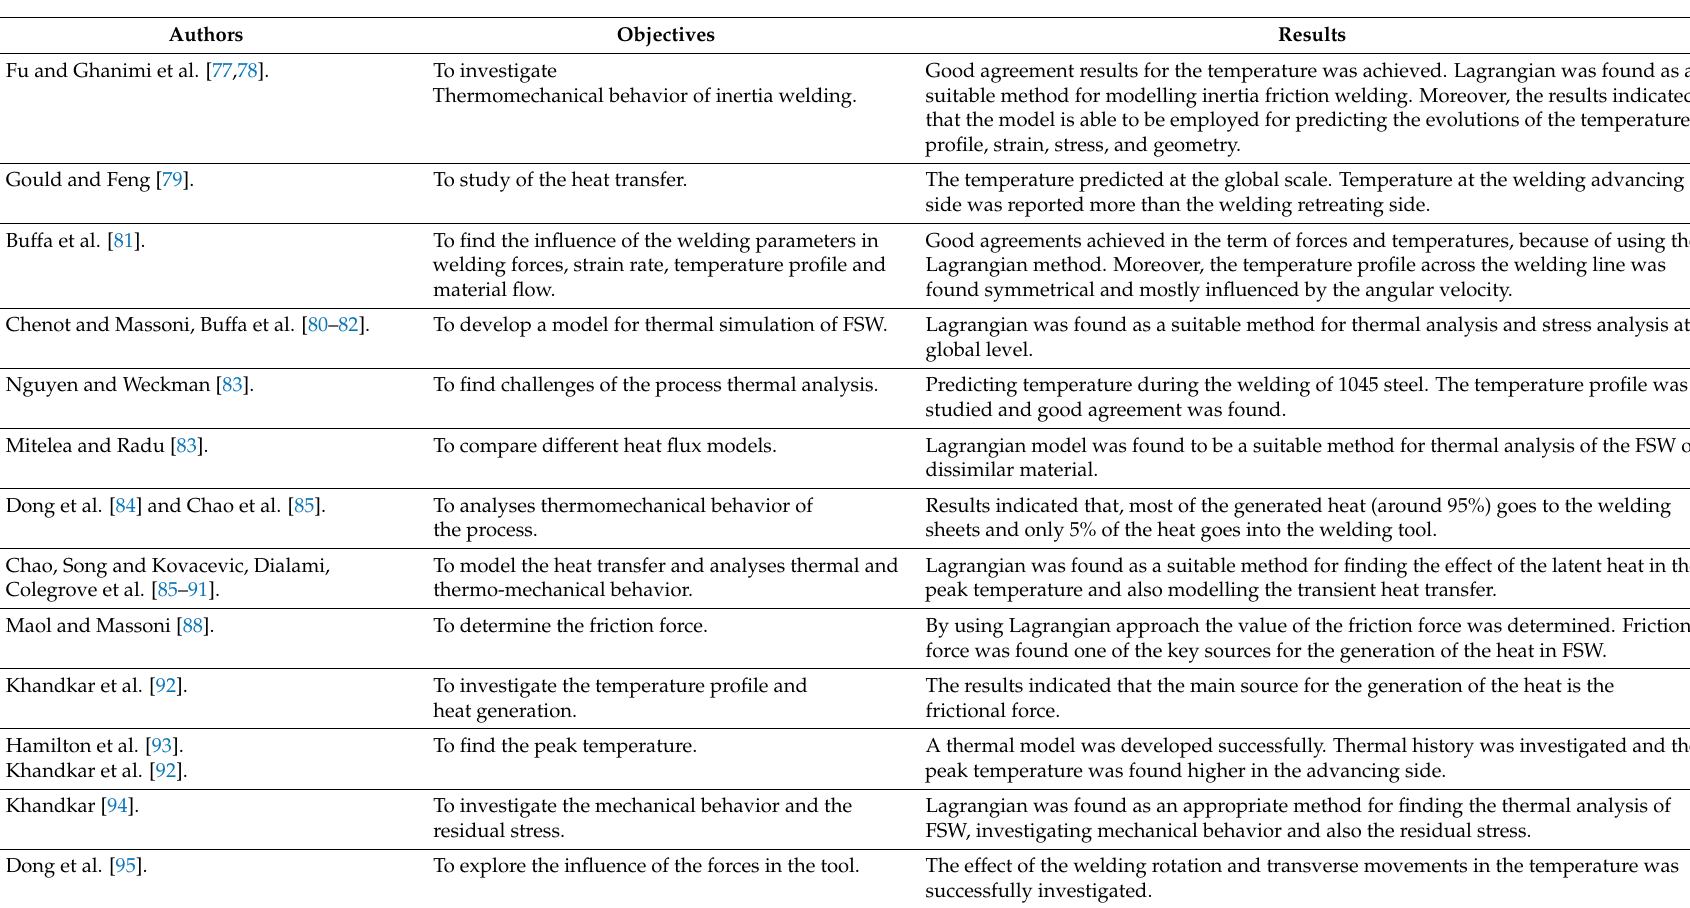
Table 3. Summary and an outlook of the research which used the Lagrangian and Eulerian